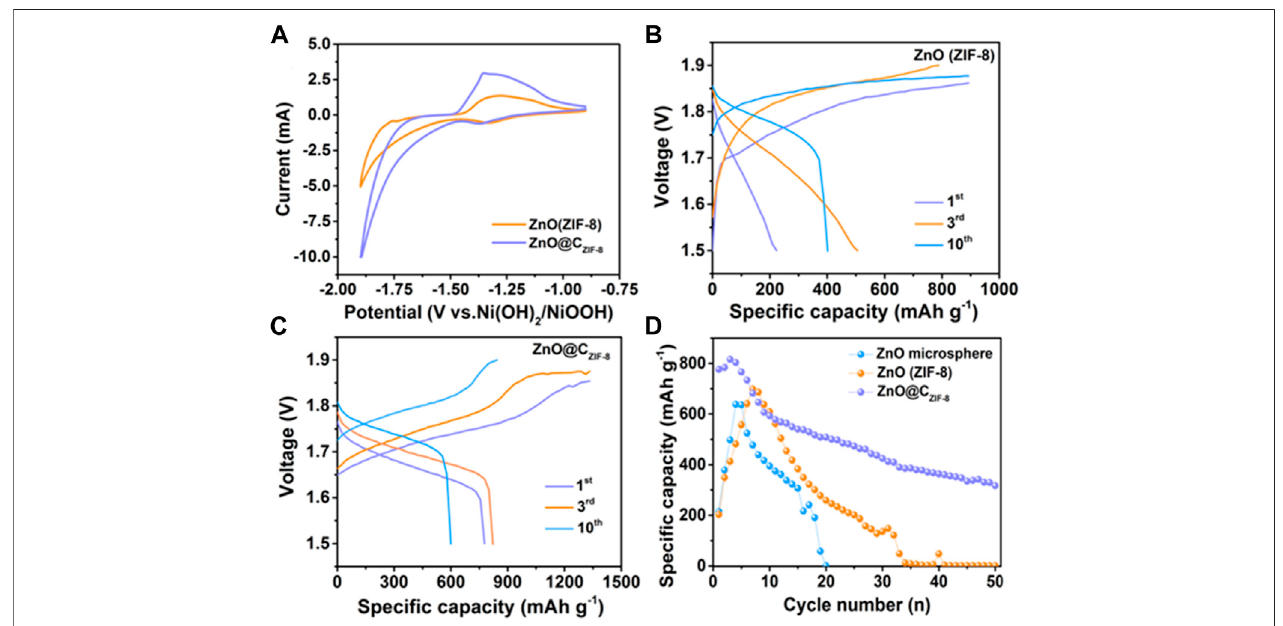
FIGURE5|(A) Cyclic voltammogram curvesofZnO(ZIF-8)and ZnO@C ZIF-8 .Galvanostaticcharge anddischargecurves of (B) ZnO(ZIF-8)and (C) ZnO@C ZIF-8 at 1st, 3rd, and 10th cycles. (D) Cycling performance of ZnO microsphere, ZnO (ZIF-8), and ZnO@C ZIF-8 at 1 A g − 1 .